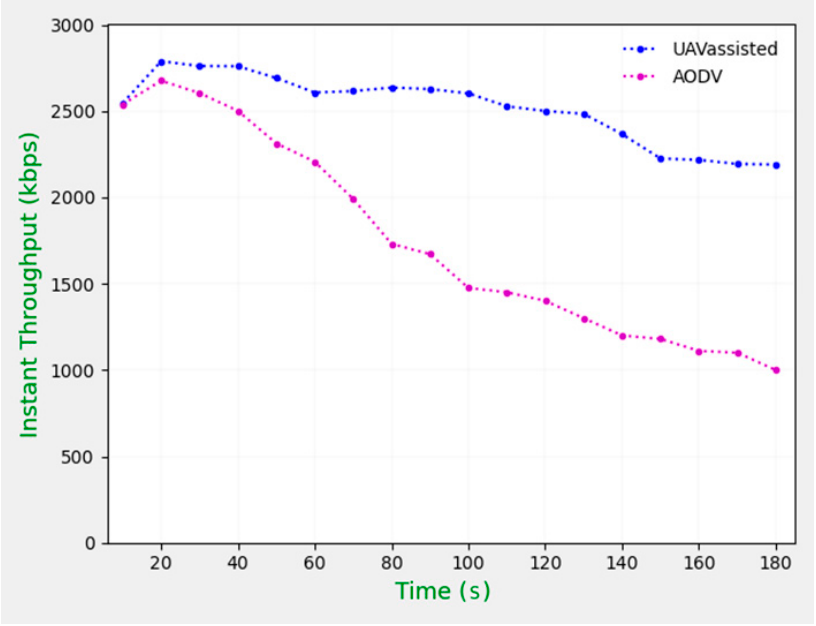
Figure 6. Instant throughput.